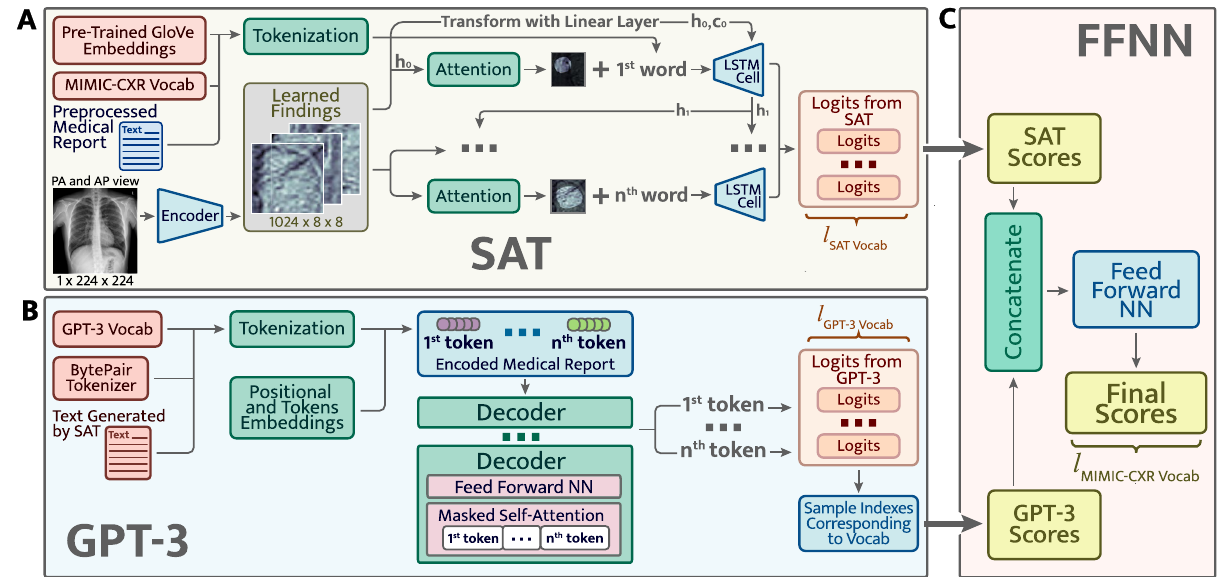
Figure 2. The first approach. Learn the joint distribution of two models.